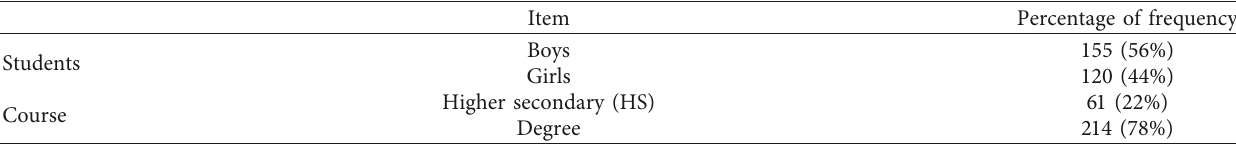
Table 3: Demographic depiction of the respondents.